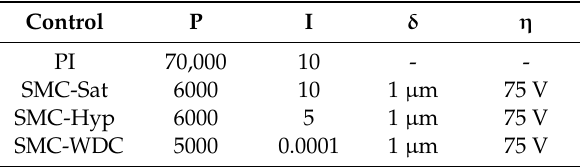
Table 2. Control parameter